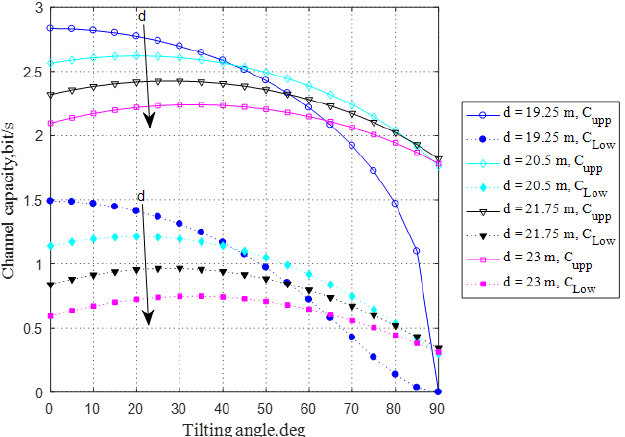
Figure 3. Capacity bounds versus tilted angle in the UWOC system.